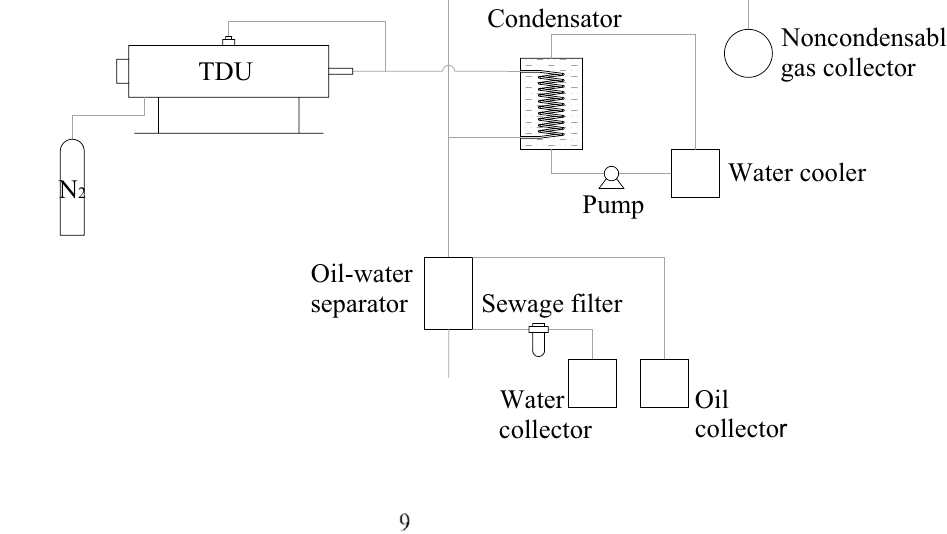
Fig. 1 Thermal desorption experiment system and process